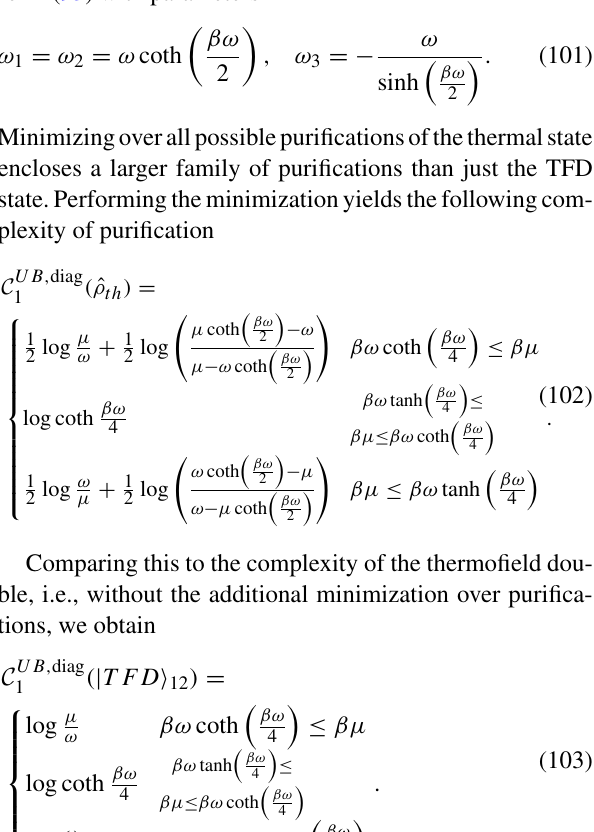
Fig. 9 Plot illustrating the three regimes of the complexity of the ther- mofield double state and the complexity of purification of the ther- mal state. The gray dashed curve indicates our choice of the reference state scale (in this case we have chosen βμ = 7) and depending on whether it is higher or lower than the red and blue curves (the func- tions βω tanh (βω/ 4 ) and βω coth (βω/ 4 ) ) tells us which is the relevant complexity regime in Eqs. (102) and (103). Only in the small range of frequency indicated in purple will the thermofield double be the optimal purification of the thermal